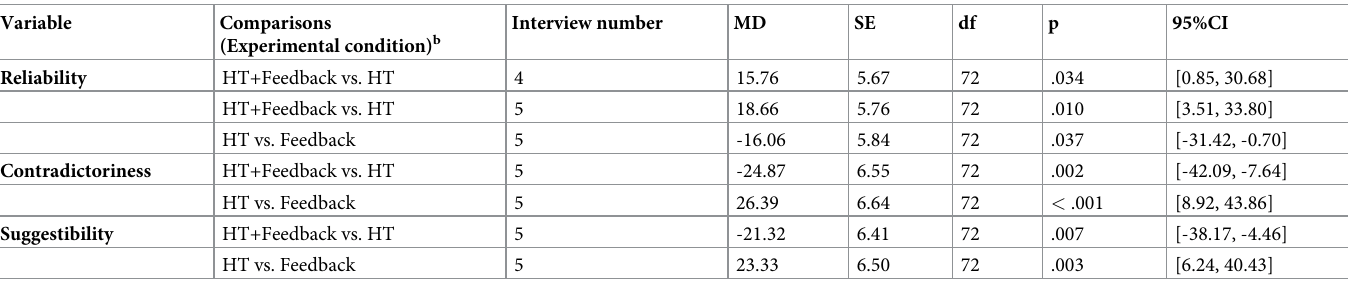
Table 8. a, c Planned comparisons on the assessment of information from avatars between experimental conditions over time. Variable